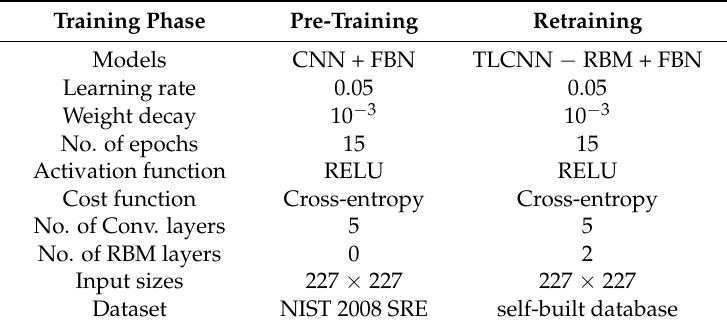
Table 4. Proposed network architectures and settings.